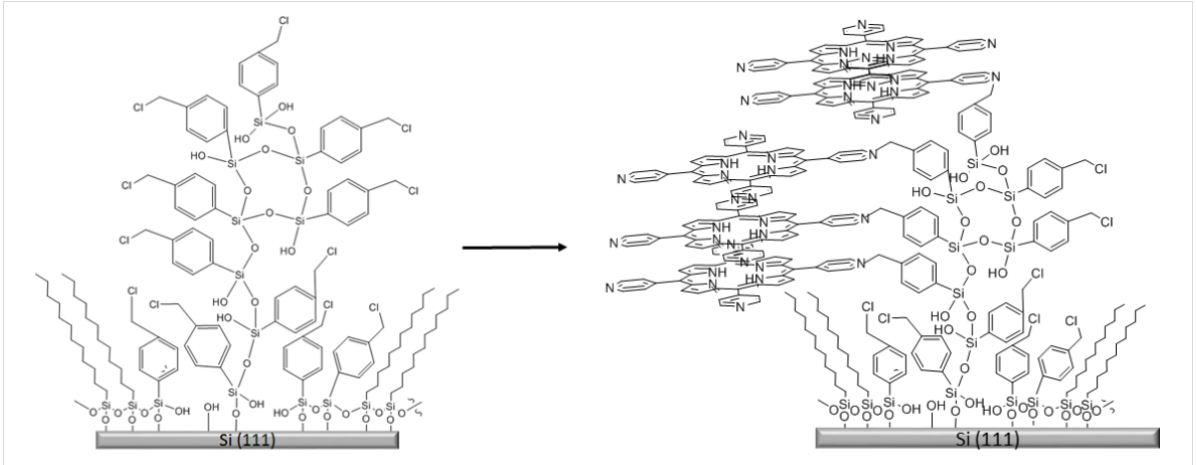
Figure 5: Model for the self-assembly of CMPS-porphyrin heterostructures within an OTS matrix layer.